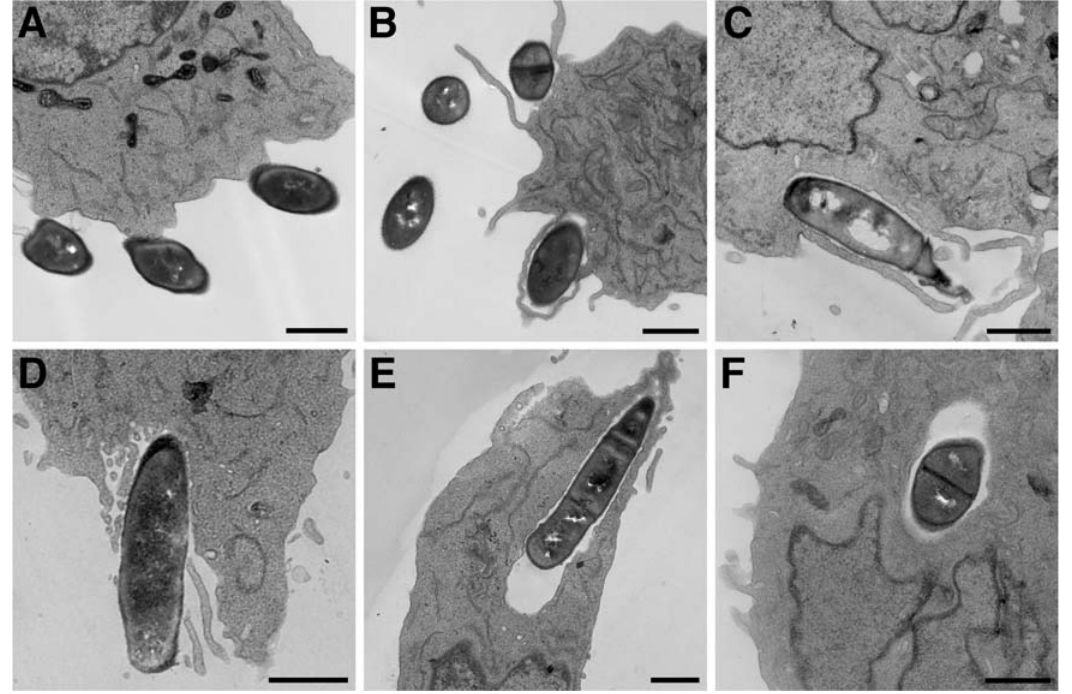
Figure 1. Transmission electron microscopy (EM) of hBMEC cells after infection with vegetative B.anthracis Sterne. (A, B) Transmission EM showing adherent B. anthracis Sterne to the cell membrane or in close proximity to microvillus projections of hBMEC. (C, D) Vegetative B. anthracis Sterne in the process of invading hBMEC or (E, F) inside membrane bound vesicles. Scale bar: 1 m m